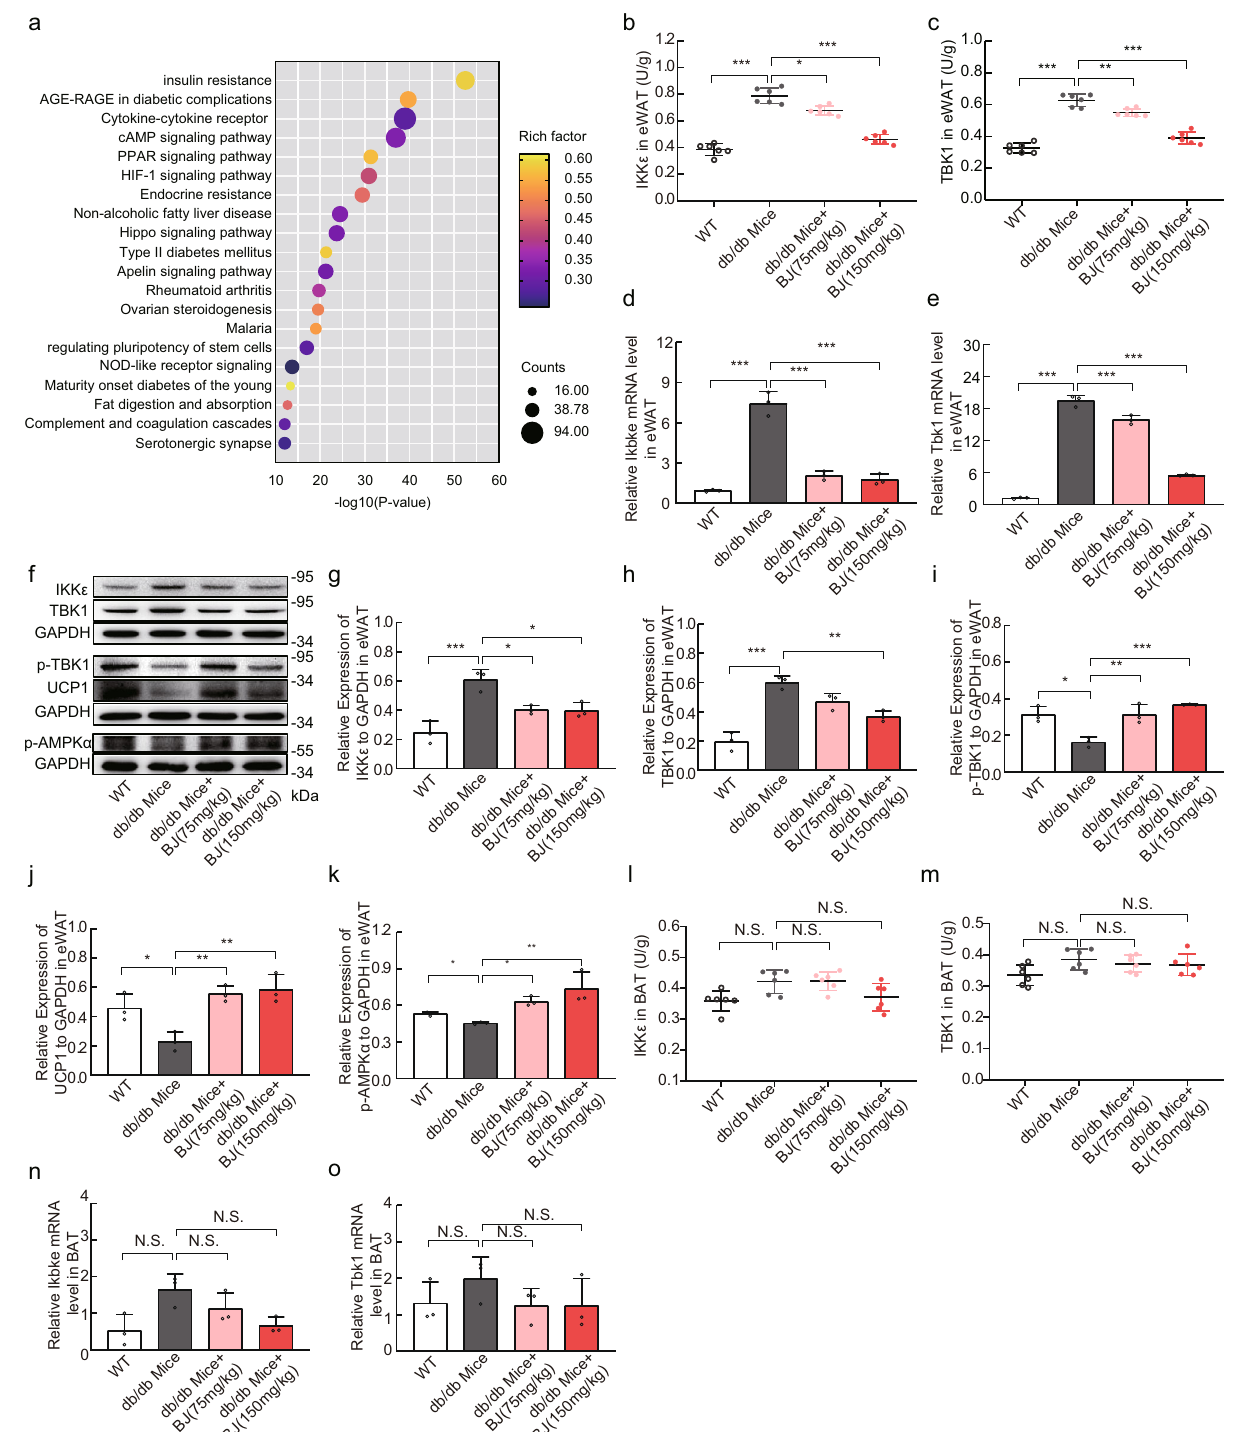
Fig. 6 BJ inhibits the expression of IKK ε and TBK1 in eWAT of db/db mice, but has no effect on BAT. a Top 20 enriched pathways of the KEGG database after identi fi cation of the genes associated with obesity. b , c IKK ε and TBK1 kinase activity in the eWAT of WT and db/db mice ( n = 6 per group). d , e RT- qPCR analysis of the relative expression levels of Ikbke and Tbk1 in eWAT of WT and db/db mice ( n = 3 per group). f – k Relative protein levels of IKK ε , TBK1, p-TBK1, UCP1, and p-AMPK α in eWAT of WT and db/db mice by western blotting ( n = 3 per group). l , m IKK ε and TBK1 kinase activity in the BAT of WT and db/db mice ( n = 6 per group). n , o RT-qPCR analysis for mRNA expression levels of Ikbke and Tbk1 in BAT ( n = 3 per group). Data are expressed as mean ± SD. NS not signi fi cant, * P < 0.05, ** P < 0.01, *** P <